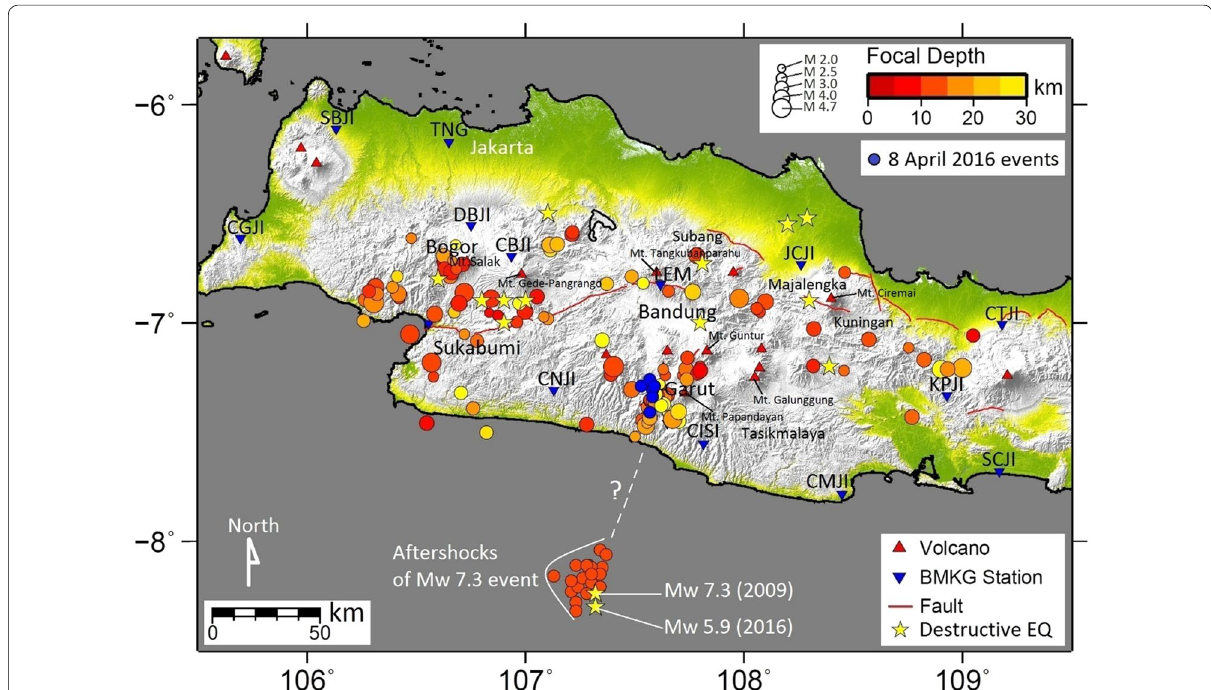
Fig. 5 Relocated earthquakes overlayed with destructive earthquakes in West Java (yellow stars) taken from previous studies (Supartoyo 2008; Musson 2012). The 2009 and 2016 events are probably related to the Garut cluster. Blue dots are the six earthquakes occurring within 48 h after the 2016 event; the black line is the fault taken from Irsyam et al. (2017). Red triangles depict volcanoes in West